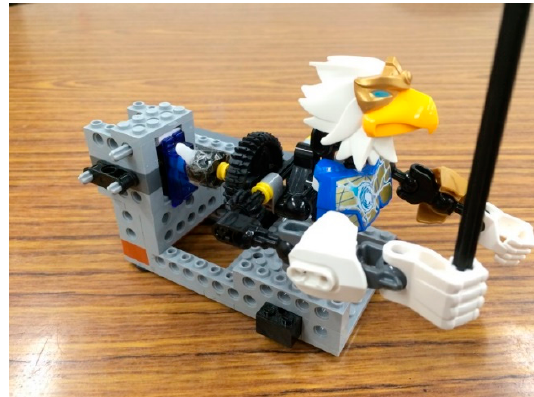
Figure 9. Appearance of the robot.